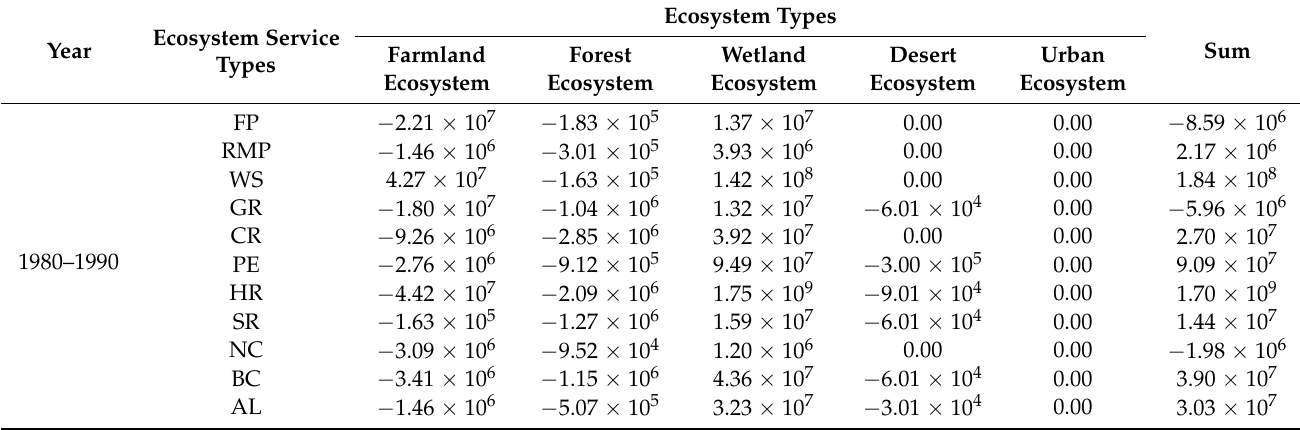
Table 7. Ecosystem service value ($) changes of different ecosystem